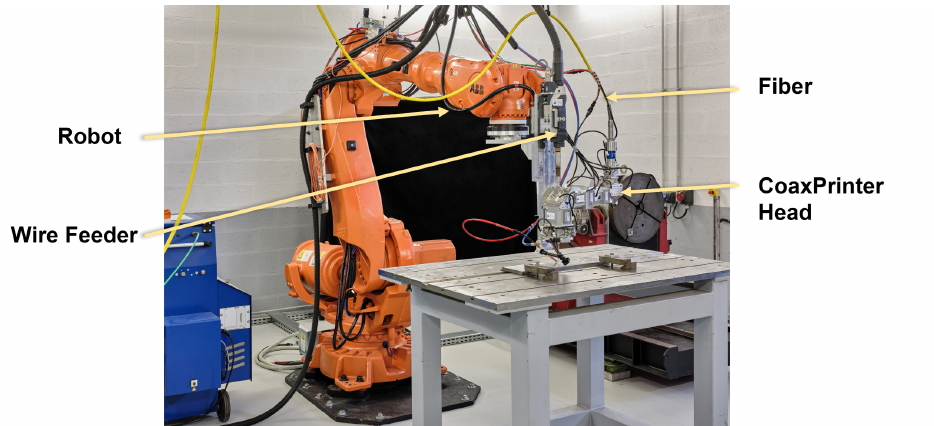
Figure 6. Experimental Setup of LWAM platform at Institut de Soudure.